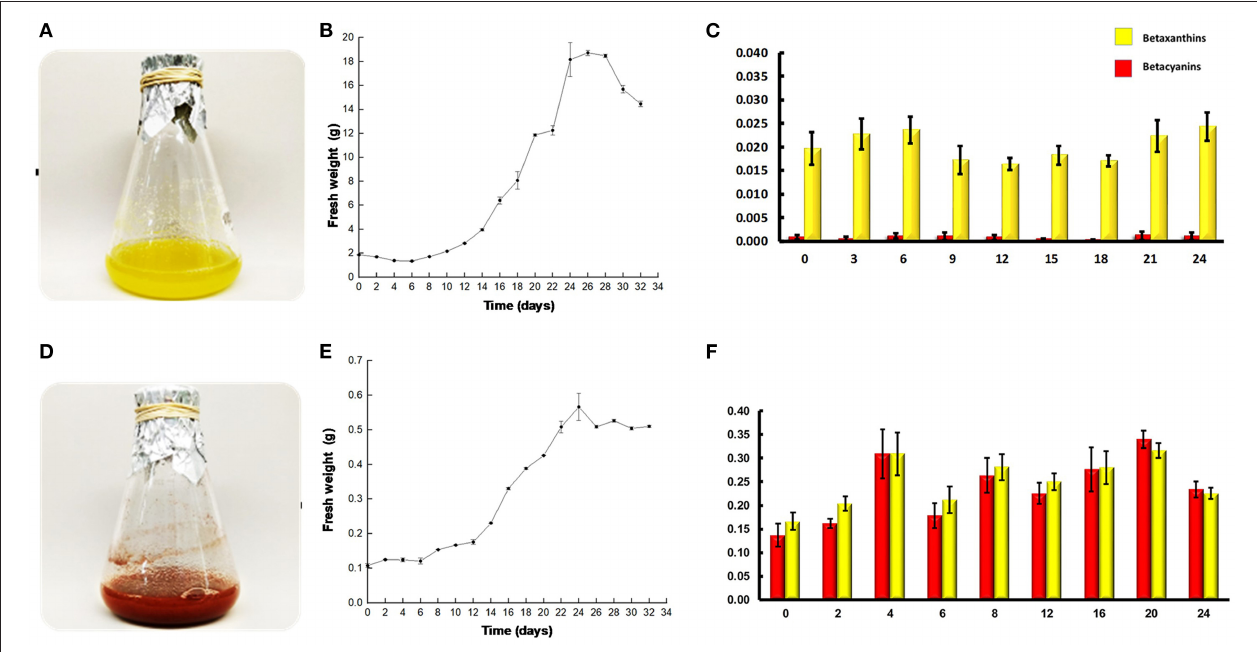
FIGURE 1 | Pitaya cell grow and betalain quantification. (A) SqY1 suspension cell Erlenmeyer flask. (B) SqY1 culture cycle grow curve (fresh weigh). (C) Betalain quantification during culture cycle. (D) SqR1 suspension cell Erlenmeyer flask. (E) SqR1 culture cycle grow curve (fresh weigh). (F) Betalain quantification during culture cycle.